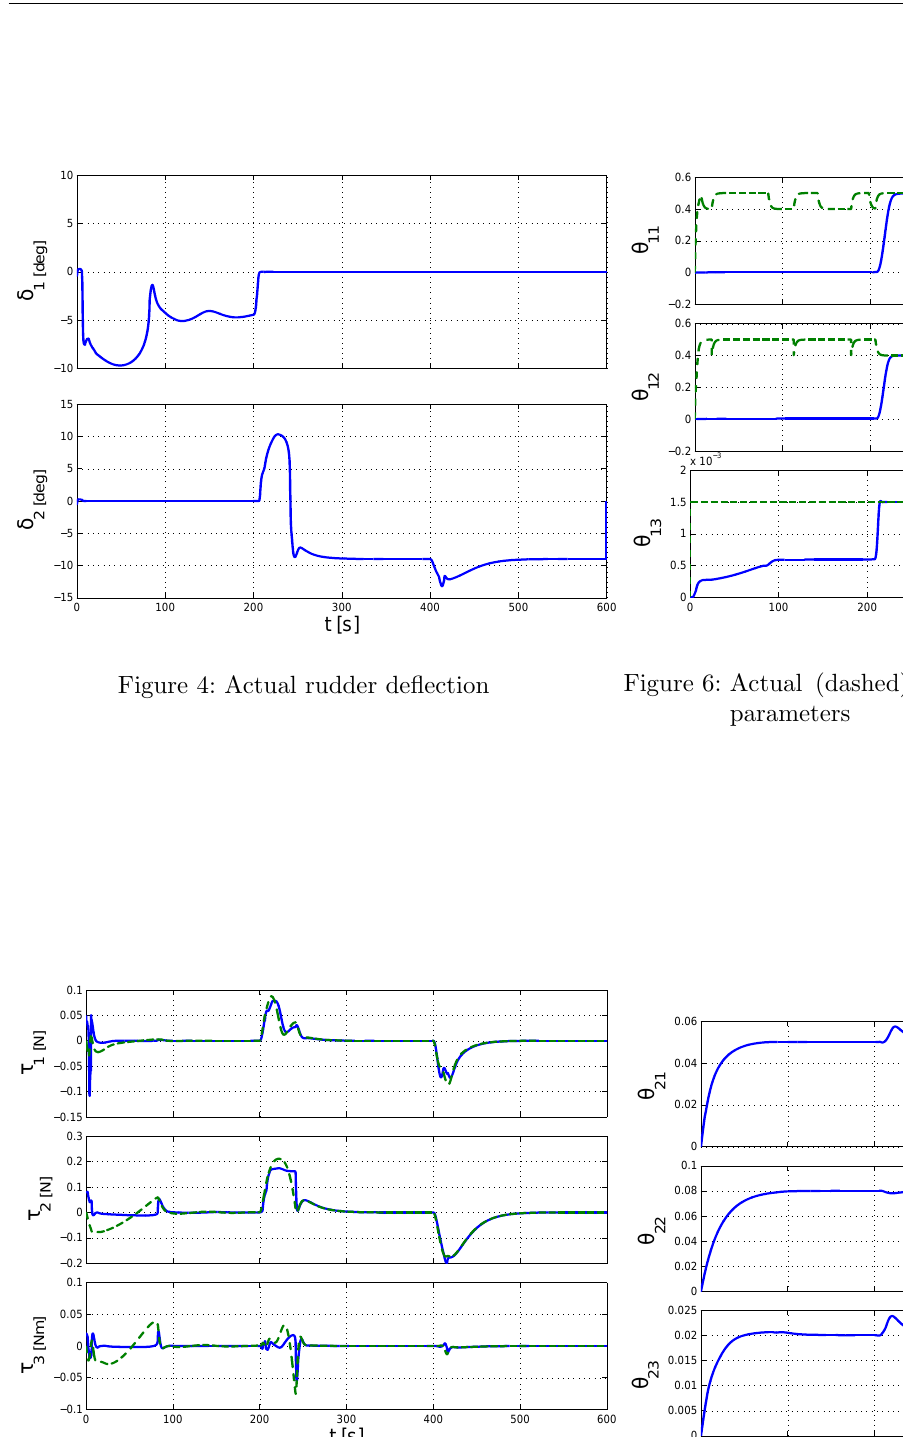
Figure 7: Effector model parameter